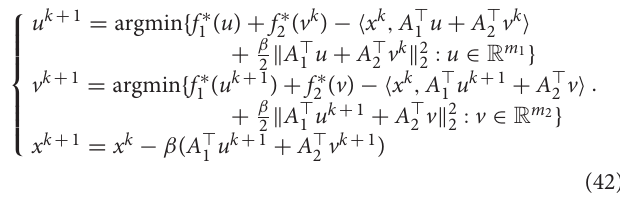
TABLE 1 | Numerical results for the L2-TV model for images blurred by the (21 , 10)-GBM. Method